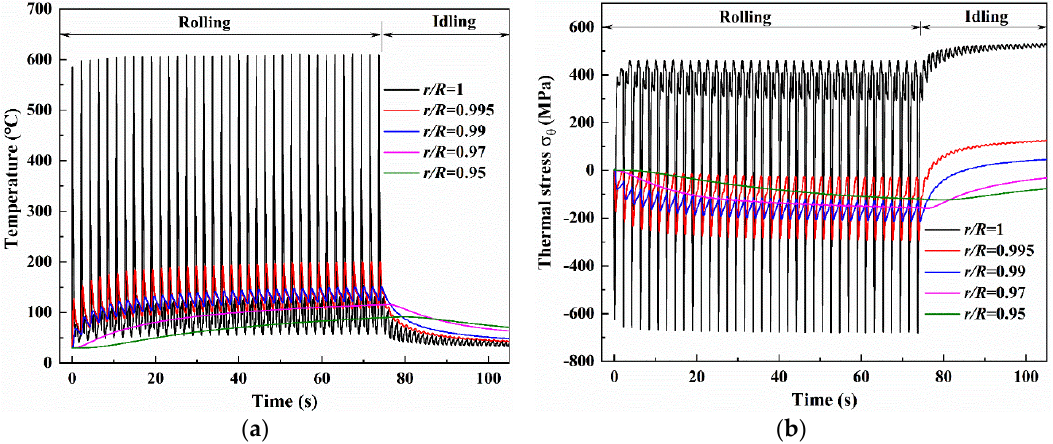
Figure 3. Histories of temperature and thermal stress with the di ff erent depths during the whole hot rolling of one strip and the subsequent idling: ( a ) temperatures, ( b ) thermal